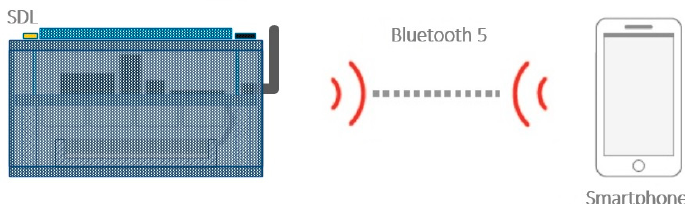
Figure 14. Smart Data Logger Bluetooth5 link to a Mobile Device .